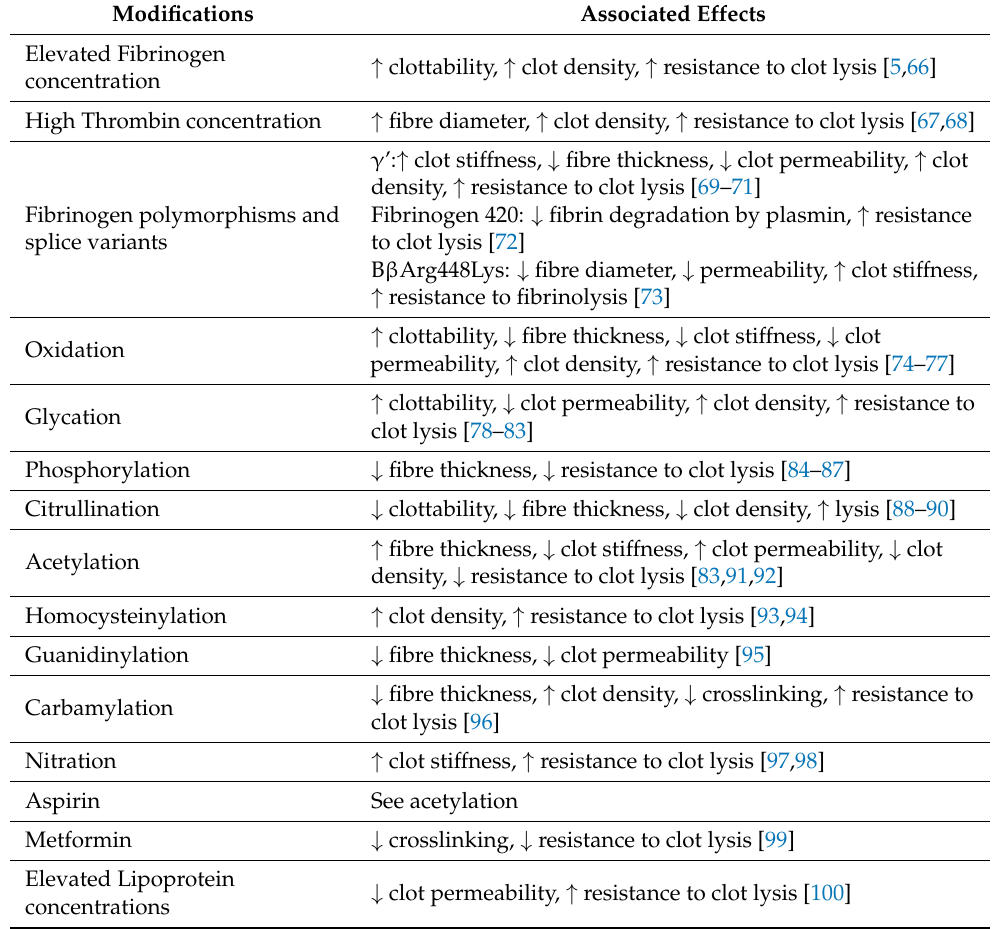
Table 1. The effects of fibrinogen modifications on clot